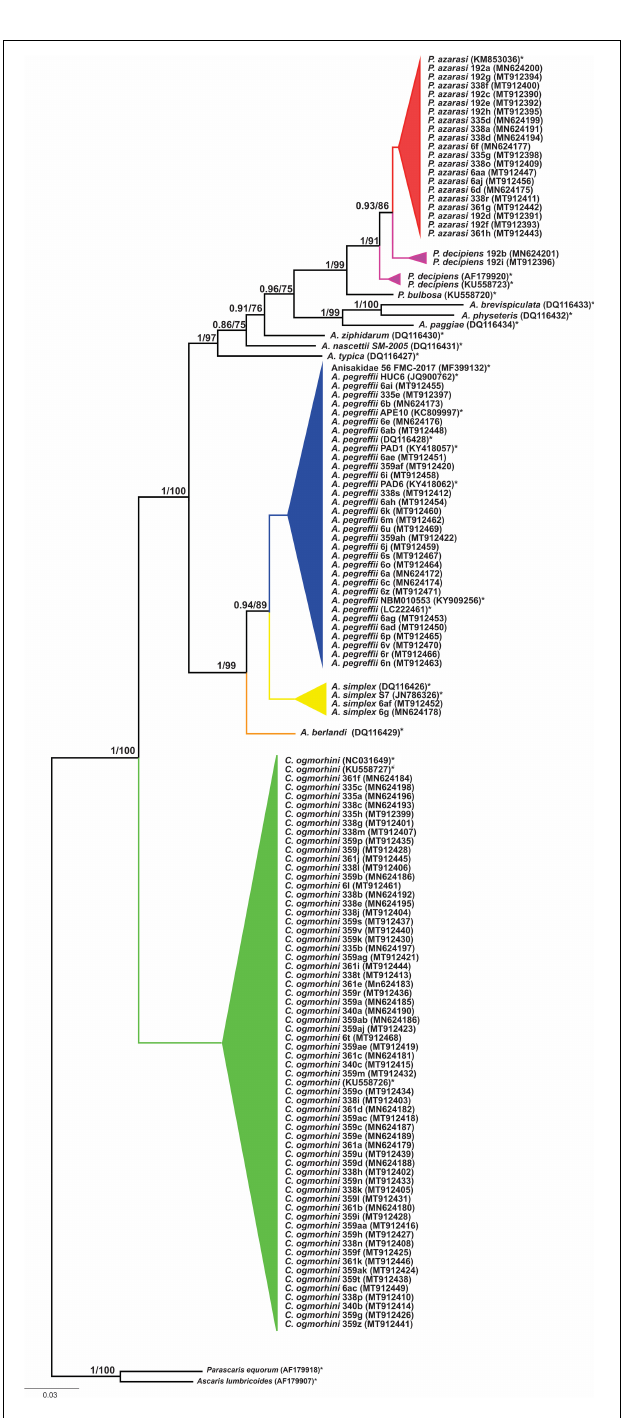
FIGURE 6 | Phylogenetic tree reconstructed from 601 bp sequence cox2 of Anisakidae. The values on the top branches correspond to posterior probabilities and bootstrap support.